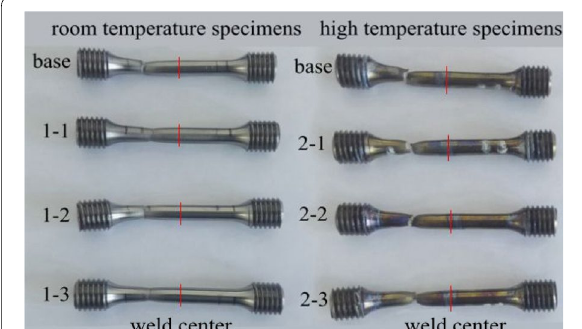
Figure 13 View of tensile specimens after tests